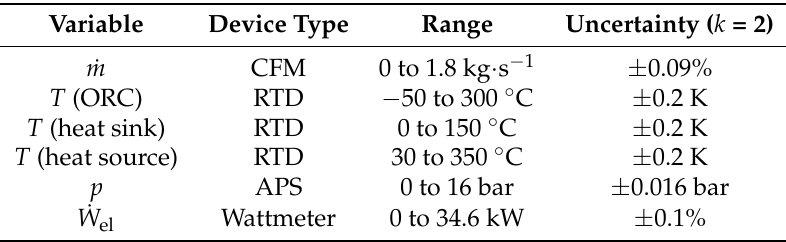
Table 3. Range and precision of the measurement devices installed on the ORC test rig. k : coverage